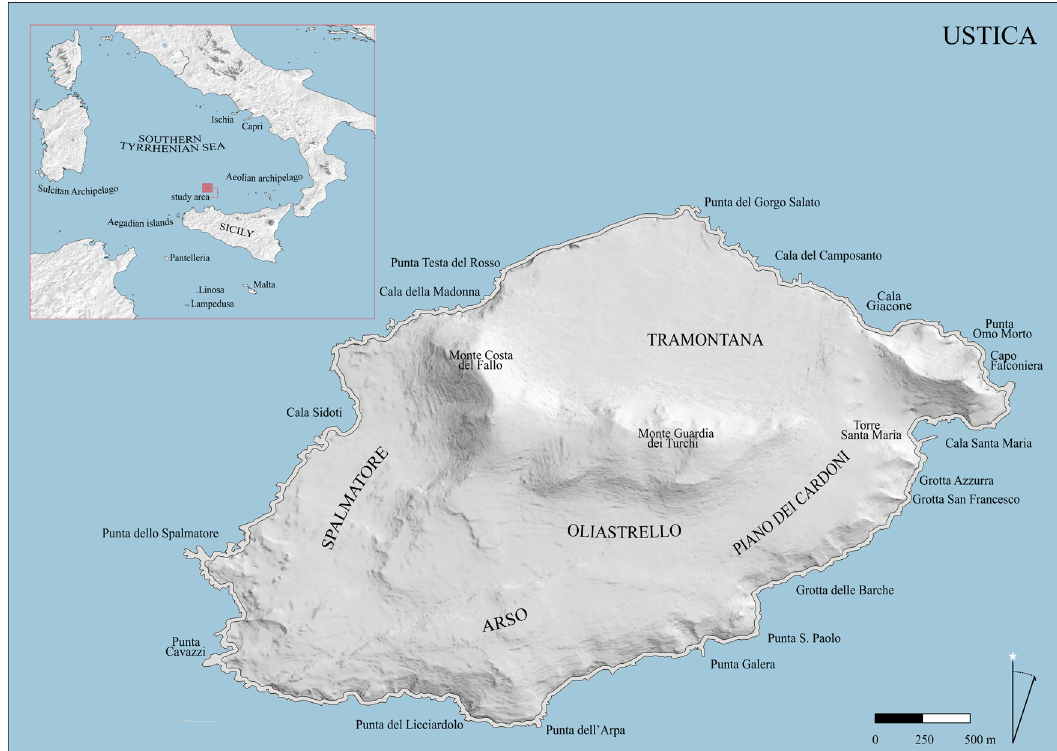
Figure 2: Ustica in the Southern Thyrrenian and names of the areas of the